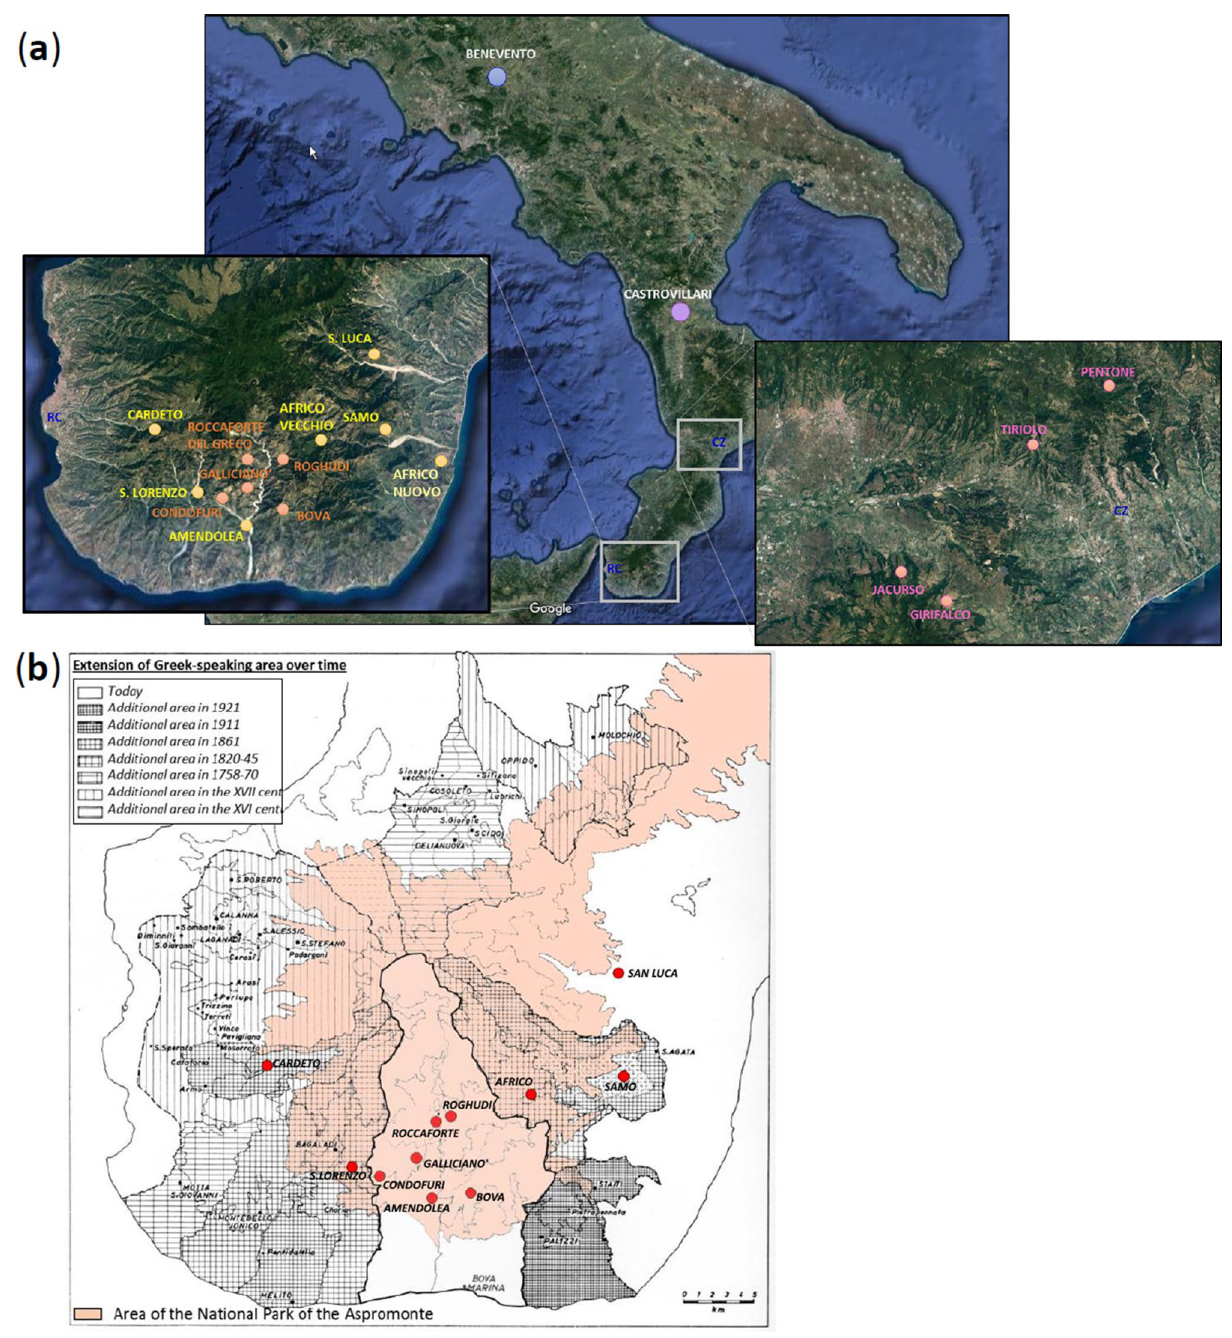
Figure 1. ( a ) Sampling map showing the approximate geographic location of analyzed populations. Sampling points are color-coded according to the province of origin: Benevento ( blue ); Castrovillari ( purple ); Catanzaro ( magenta ); previously collected samples from Reggio Calabria ( orange ); newly collected samples from Reggio Calabria ( gold ). The two enlarged boxes detail the sampling locations of villages in the province of Reggio Calabria (left) and in the province of Catanzaro (right), respectively. ( b ) Historical map showing the approximate extension of the National Park of the Aspromonte mountain area (in pink) as well as the range of the Greek-speaking area at different time periods as reported in the legend at the top-left. Geographical map has been generated with the package RgoogleMaps [v. 1.4.1] 92 (URL: http://www.jstat soft.org/v63/i04/) of the software R [v. 3.2.4] (https ://www.r-proje